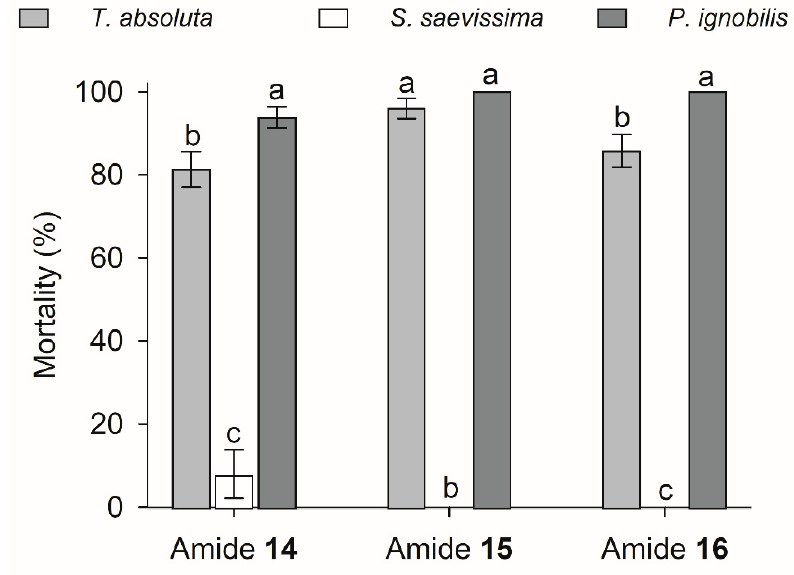
Figure 4. Mortality (%) caused by LD 80 of amides 14 , 15 , and 16 to Tuta absoluta larvae and the predators Solenopsis saevissima and Polybia ignobilis , 48 hours after topical exposure. Means followed by the same letter in each column group (amide) do not differ by Tukey’s test ( P < 0.05).